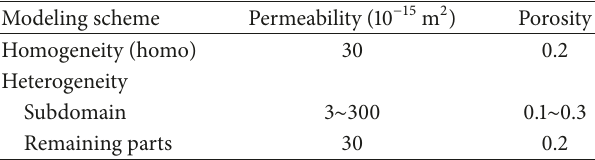
Table 3: Parameter setting of different modeling scheme. Modeling